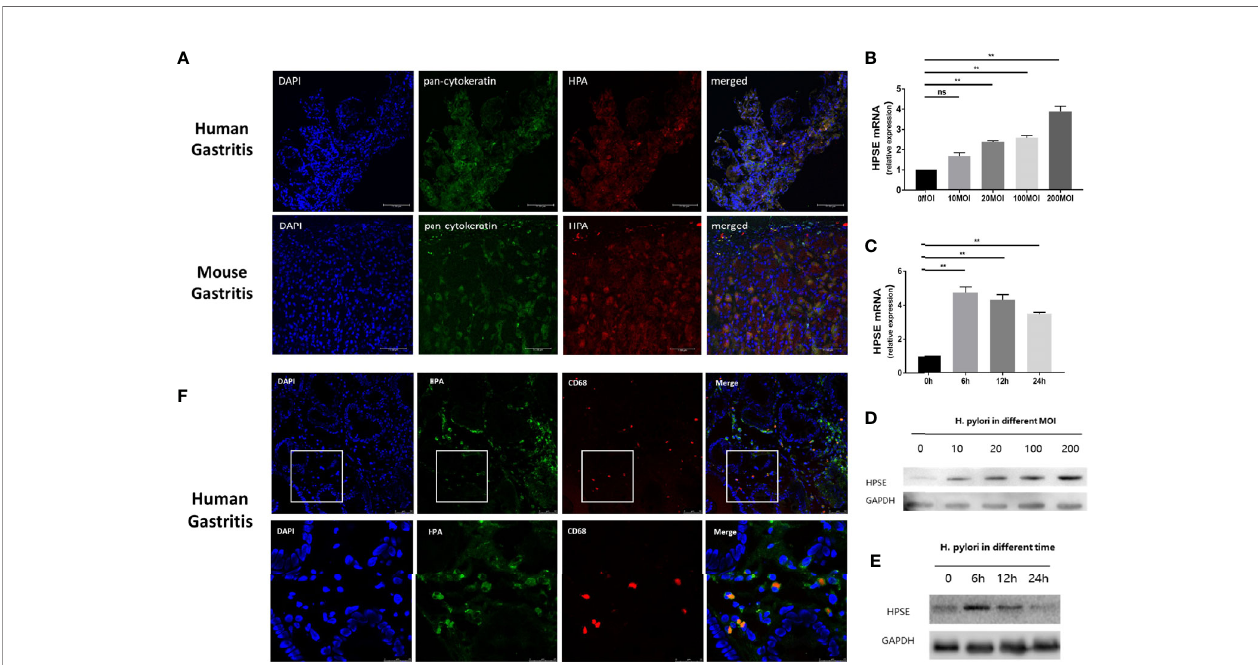
FIGURE 4 | H. pylori induce the expression of heparanase in gastric epithelial cells and macrophages. (A) Immuno fl uorescent staining. H. pylori -positive human (upper panels) and mouse (lower panels) gastric tissue were collected and 5-micron sections were subjected to immuno fl uorescent staining applying anti-pan- cytokeratin (AE1/AE3, green) and anti-heparanase (red) antibodies. Images merged with nuclear staining (DAPI, blue) are shown in the right panels. Blue: cell nuclei; Green: anti-pan-cytokeratin monoclonal antibody, Alexa fl uor 488; Red: primary, anti-heparanase antibody 733; secondary, cy3-labeled Goat Anti-Rabbit IgG antibody. (B, C) qPCR. H. pylori strain PMSS1 were co-cultured with GES-1 normal human gastric mucosa epithelial cells (n = 3 for each MOI) at the indicated multiplicity of infection (B , MOI ) for 6 h. Total RNA was then extracted and subjected to qPCR applying a primer set speci fi c for heparanase. Heparanase levels are shown graphically relative to its expression in control cells without the bacteria (0), set arbitrarily to a value of 1. Cells were similarly grown with H. pylori (200 MOI) for the indicated time (n = 3 for each time point) and heparanase expression was quanti fi ed by qPCR (C) . (D, E) Immunoblotting. GES-1 normal human gastric mucosa epithelial cells were similarly grown with H. pylori at the indicated MOI for 6 h. Cell extracts were then prepared and subjected to immunoblotting applying anti- heparanase (upper panel) and anti-GAPDH (lower panels) antibodies (D) . GES-1 cells were similarly grown with the bacteria (200 MOI) for the time indicated and cell lysates were subjected to immunoblotting as above (E) . (F) H. pylori -positive human gastric tissue samples were collected and 5-micron sections were subjected to immuno fl uorescent staining applying anti-heparanase (green) and anti-human CD68 (red, Alexa Fluor 647) antibodies. Merged images and nuclear staining (DAPI, blue) are shown in the right panels. **p <0.01; ns, no signi fi cant